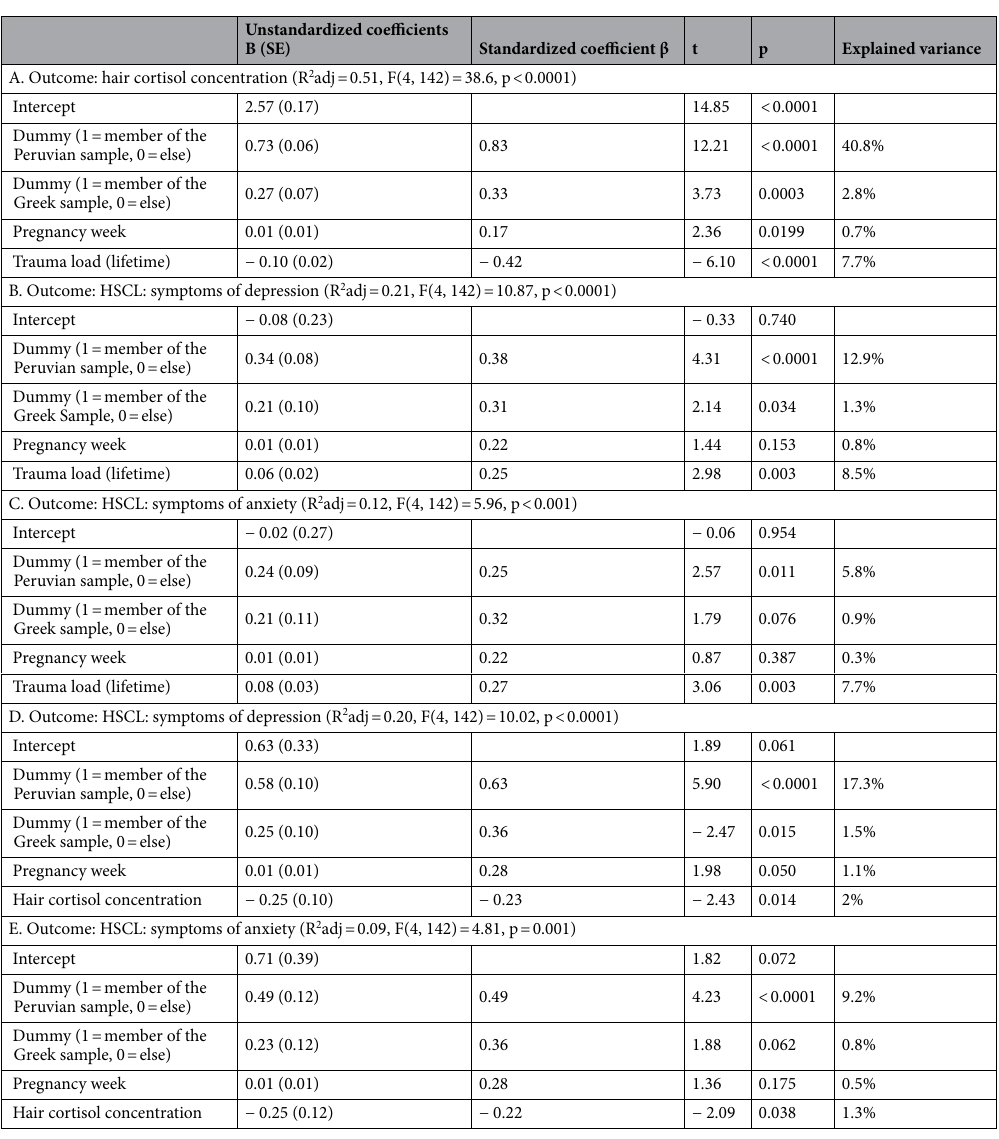
Table 2. Summary of the regression analysis in the prediction of hair cortisol concentration (A), and HSCL symptoms of depression (B, D) and anxiety (C, E). HSCL Hopkins symptom checklist-25, HCC hair cortisol concentration in a scalp-near segment of 2 cm